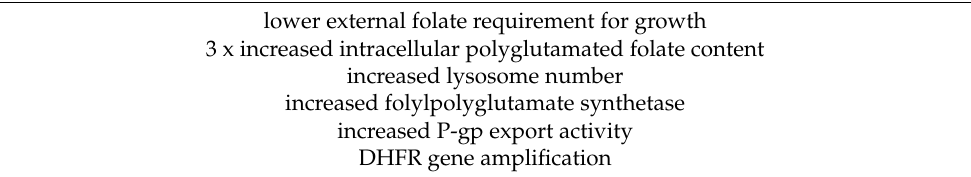
Table 4. Characteristic changes seen in mammalian cells that are associated with reduced cytotoxicity of